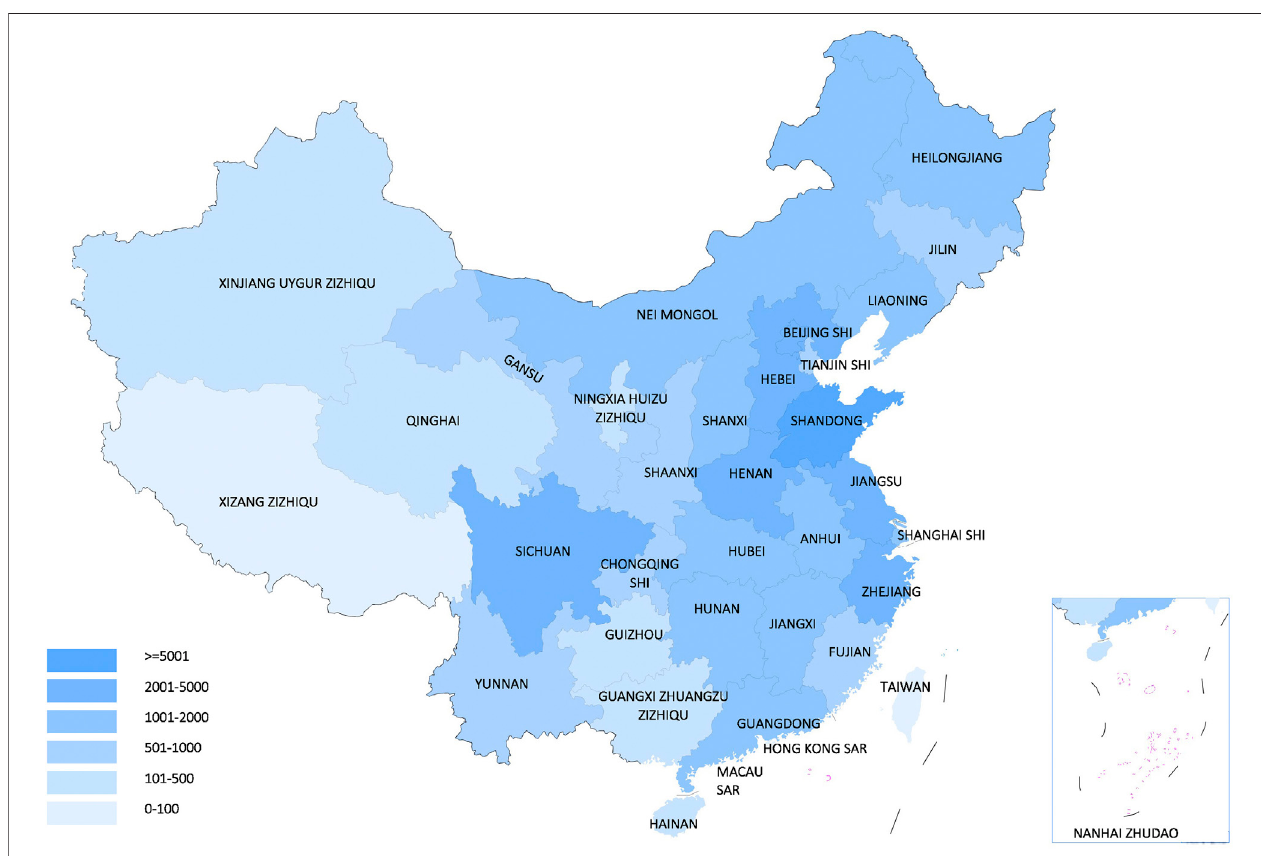
FIGURE 2 | The regional distribution map of registered patients from NRDRS (as of Mar. 24, 2021). (The National Rare Diseases Registry System of China, 2021).